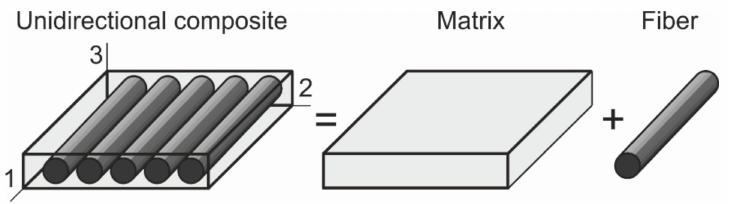
Figure 3. Scheme of a UD composite.